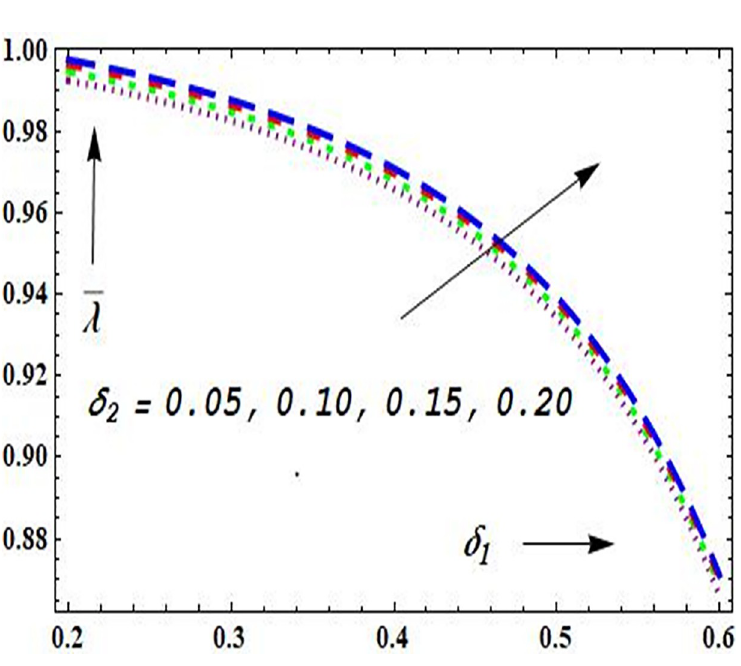
Fig 8. Plot of � λ on δ 1 and δ 2 with ϕ ¼ π